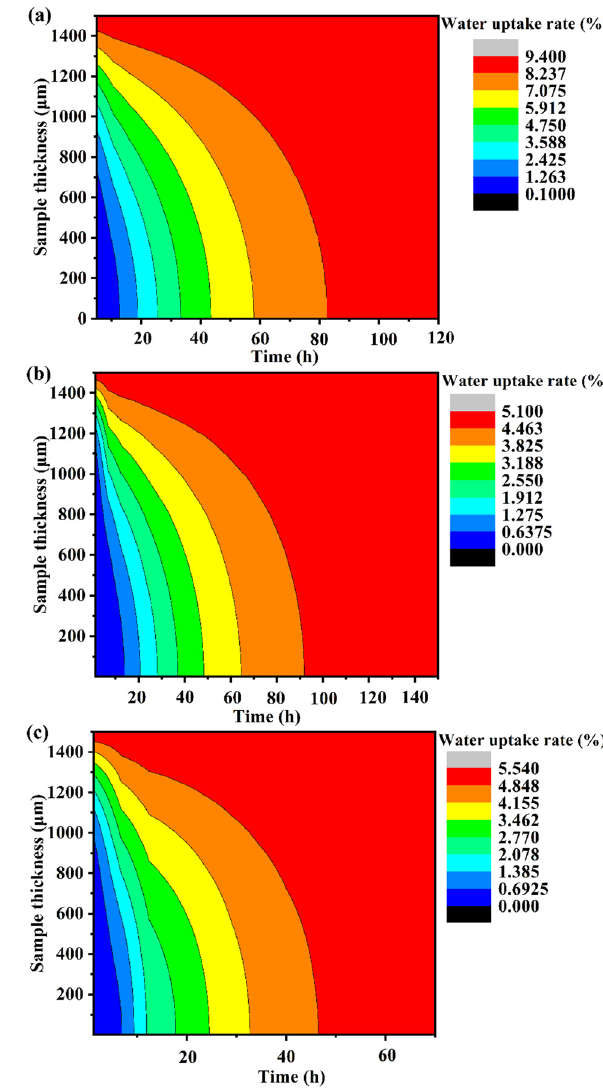
Figure 9: Water uptake pro fi les as a function of immersion time for ( a ) PA6 resin, ( b ) CF/PA6 ( Panex® 35 - 50K ) composite, and ( c ) CF/PA6 ( SYT49S - 12K ) composite; the samples are immersed in distilled water at